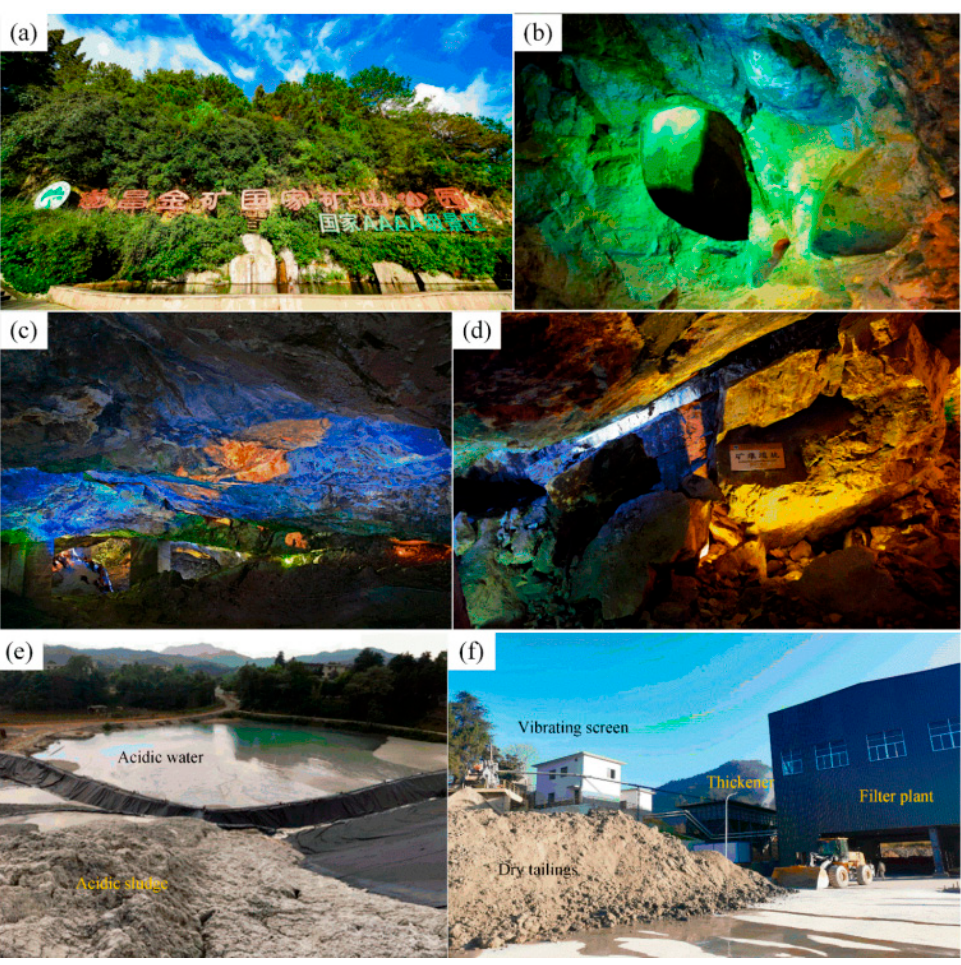
Figure 8. Construction of green mine at Suichang gold mine: ( a ) exterior view of Suichang National Mine Park; gold grottoes of ( b ) Tang Dynasty and ( c ) Song Dynasty; ( d ) mining disaster sites from Ming Dynasty; ( e ) treatment of acid water in old goaf; ( f ) comprehensive use of total dehydration of tailings (Shuai Li [114]).